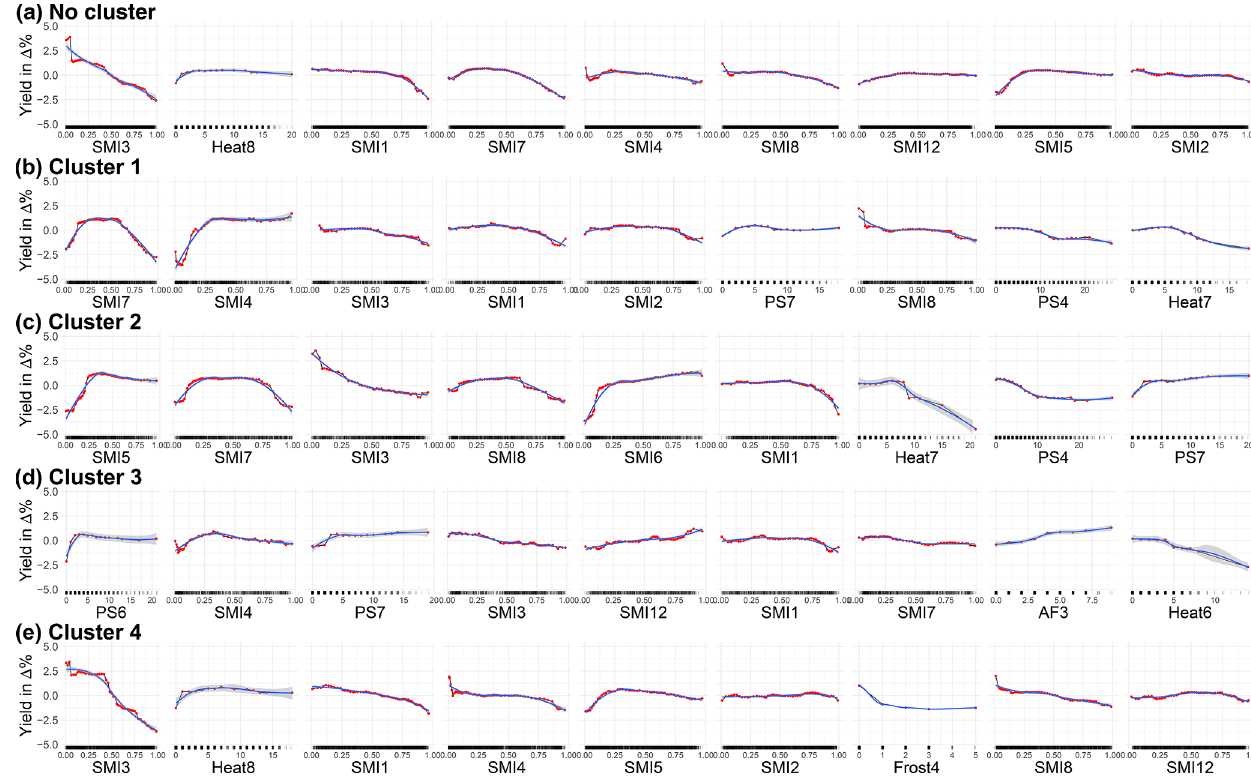
Figure 4. Accumulated local effects plots of the nine most important features for no cluster (a) , cluster 1 (b) , cluster 2 (c) , cluster 3 (d) , and cluster 4 (e) derived from PAM (4). The red dots are estimated by the ALE plot algorithm (FeatureEffects of the iml package in R). We have chosen a grid size of 50, which allows us to reveal the true complexity of the model at the expense of shakiness. Therefore a non-linear smoothing function (LOESS – locally estimated scatterplot smoothing) is added in blue (with the confidence interval in grey). SMI represents the soil moisture index for the uppermost 25cm of the soil column, PS stands for days without rain in a given month, Heat stands for days with a maximum temperature of more than 30 ◦ C, Frost stands for the number of days below − 5 ◦ C (as only April is indicated), and AF stands for days with a minimum temperature below − 3 ◦ C as well as a maximum temperature of + 3 ◦ C (same day). The number indicates the month; 10, 11, and 12 refer to the year before. For example, SMI12 represents SMI in